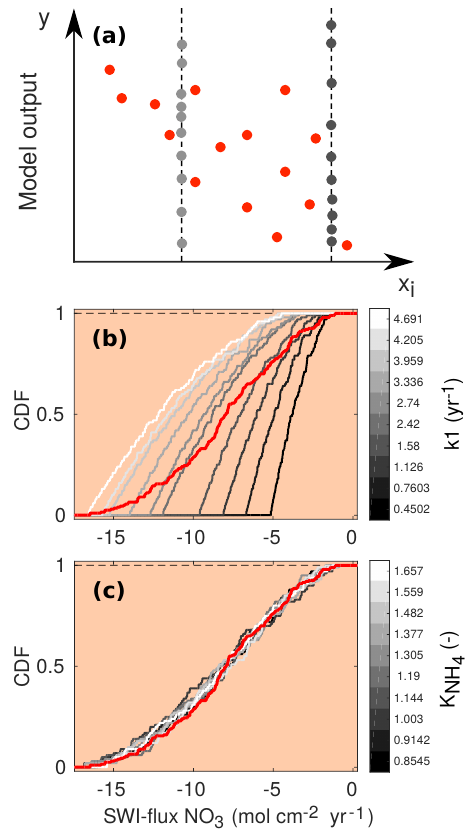
Figure 4. (a) Schematic of the PAWN method, plotting an uncer- tain parameter ( x i ) against a generic model output ( y ). Red dots represent points for calculating the unconditional CDF (NU, here 15), and grey dots are points for calculating each conditional CDF (NC, here 10) with n = 2 conditioning points as an example. The user can change the values of NU, NC and n . The number of model evaluations equals N eval = NU + n · NC · M , where M is the num- ber of uncertain input parameters. (b, c) Two examples of CDFs for the model-calculated SWI flux of NO 3 using NU = 200, NC = 100 and n = 10. The red lines are the unconditional distribution func- tions F y ( NO 3 ) and the grey lines are the conditional distribution ( NO 3 ) at different fixed values of the input parame- functions F y | x i (c) . As the maximal distance between condi- ters k 1 (b) and K NH 4 tional CDFs and unconditional CDF is greater for k 1 , this parameter is more influential for the model output (here the SWI flux of NO 3 ; compare to Fig.